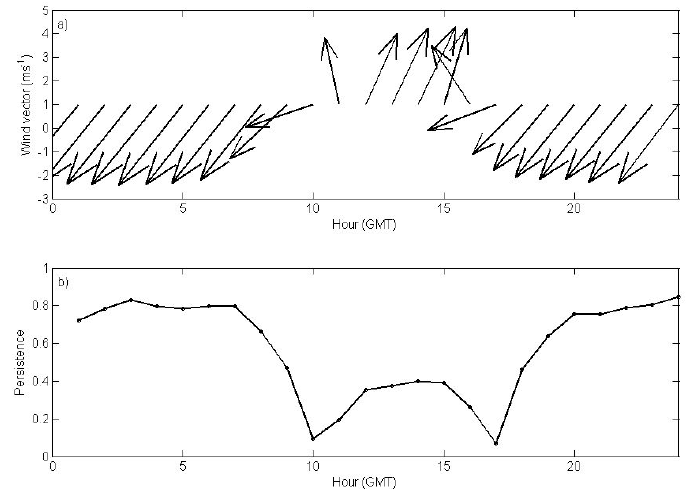
Fig. 8. (a) Diurnal cycle of the near-surface wind vector of the “representative day”, during the winter season at the Assergi site, as predicted by the Mesoscale Model 5. (b) Diurnal variation of wind persistence relative to the wind vector in the upper panel.